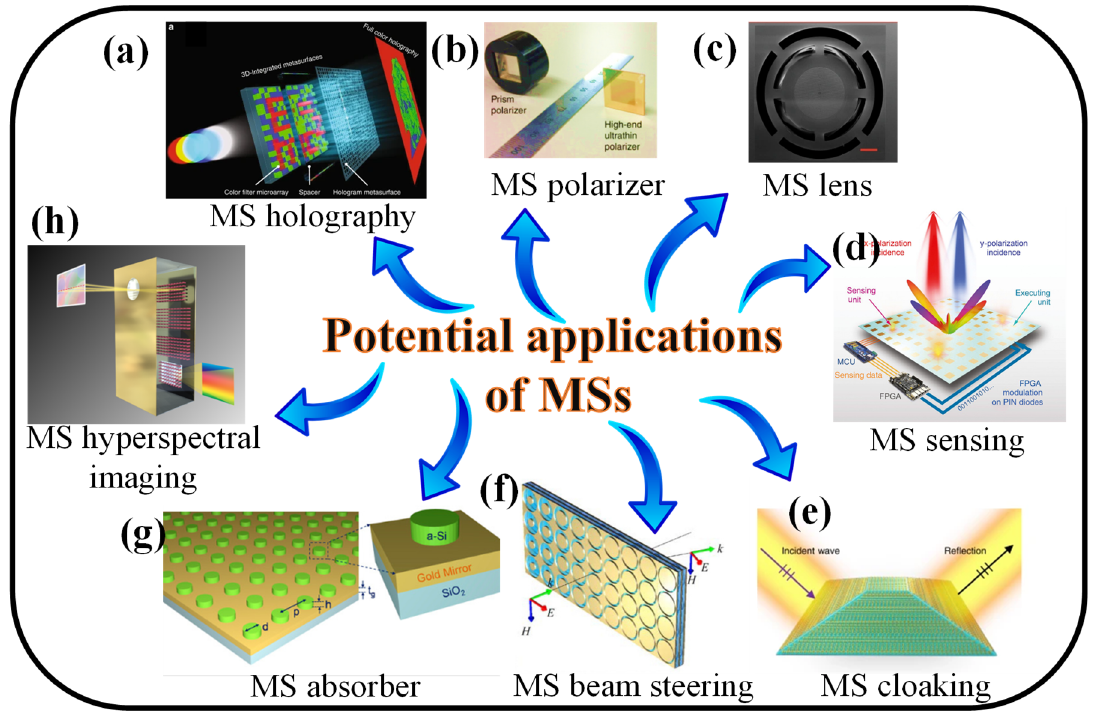
Figure 1. Some of the potential applications of MSs, ( a ) holography [31], ( b ) polarization control [32], ( c ) Lenses [33], ( d ) Sensors [34], ( e ) cloaking [35], ( f )beam steering [36], ( g )absorbers [37], and ( h ) hyperspectral imaging [38].